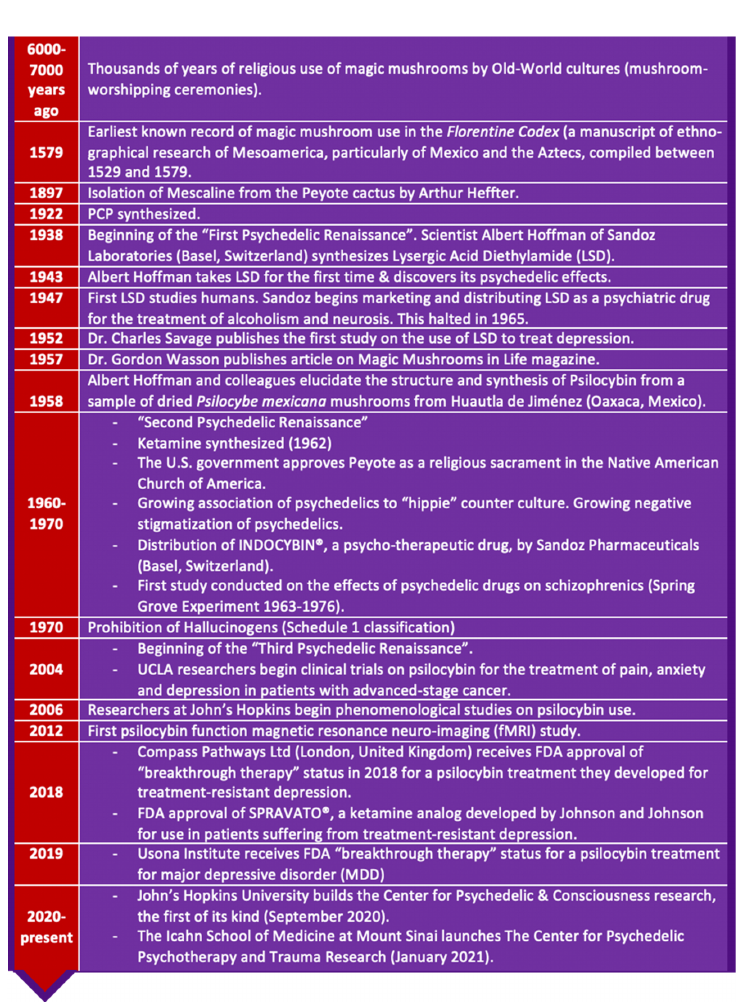
Figure 2. Historical timeline of psychedelic substances.